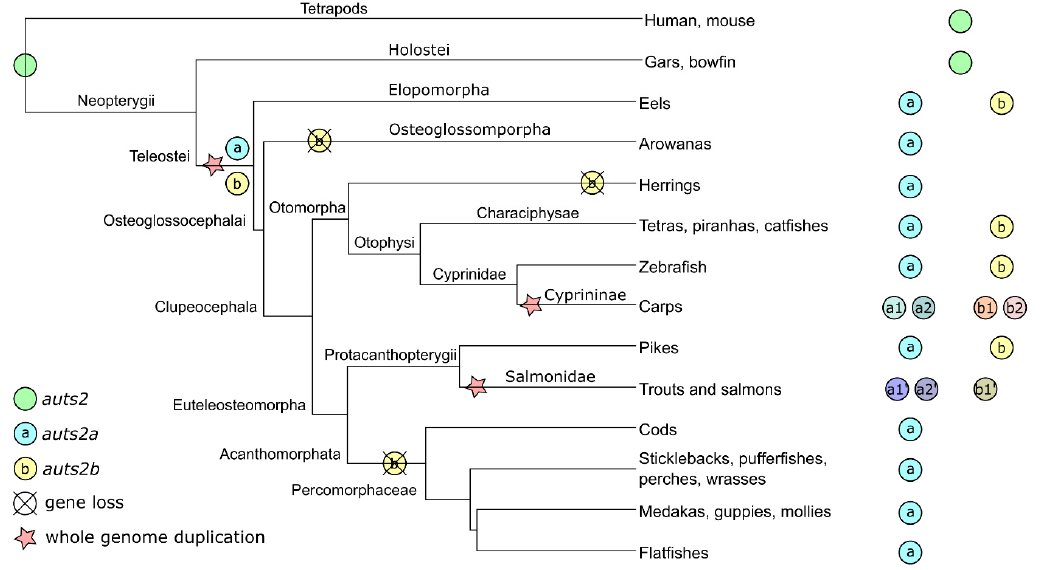
Figure 3. Teleost auts2 ohnologs’ evolutionary history. The presence of a gene in a specific clade denotes the retention in at least one species of the clade.